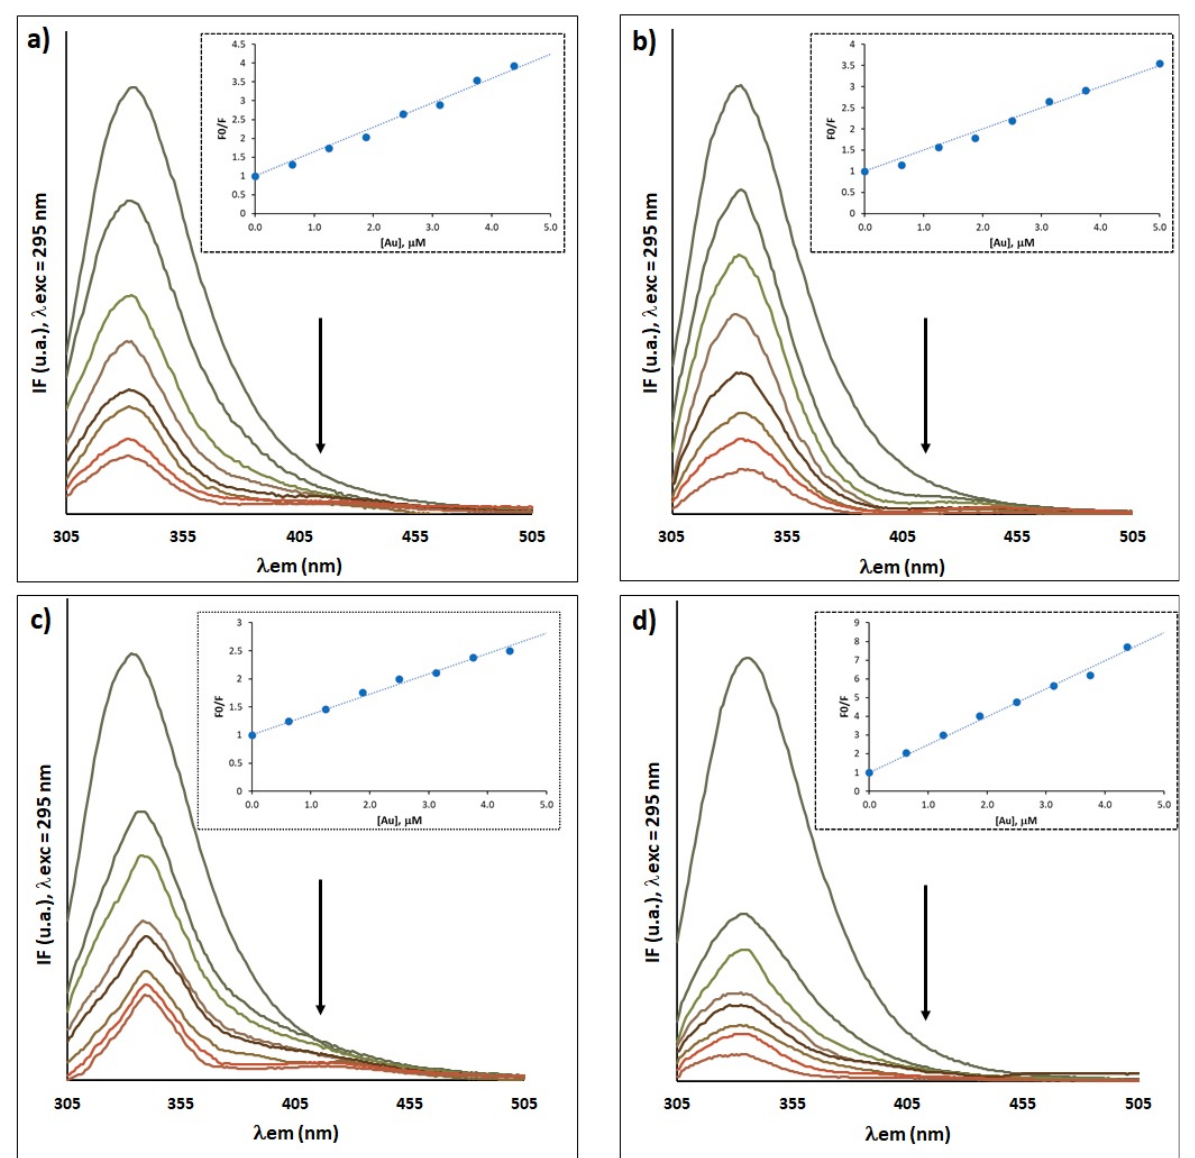
Figure 9. Fluorescence emission spectra in the absence (line with highest IF) and presence of gold complexes: ( a ) [ P ][AuSEt(=S)], ( b ) [ P ][AuSEt(=Se)], ( c ) [ P ][AuSe i Pr(=S)] and ( d ) [ P ][AuSBu(=S)]. Inset: Stern–Volmer plot at pH 7.4 of HSA–Au systems. Experimental conditions: [HSA] = 2.5 µM and [gold compound] = 0 − 5 µM, 10 mM Hepes bu ff er, pH 7.4; incubation at 37 °C during 24 h.